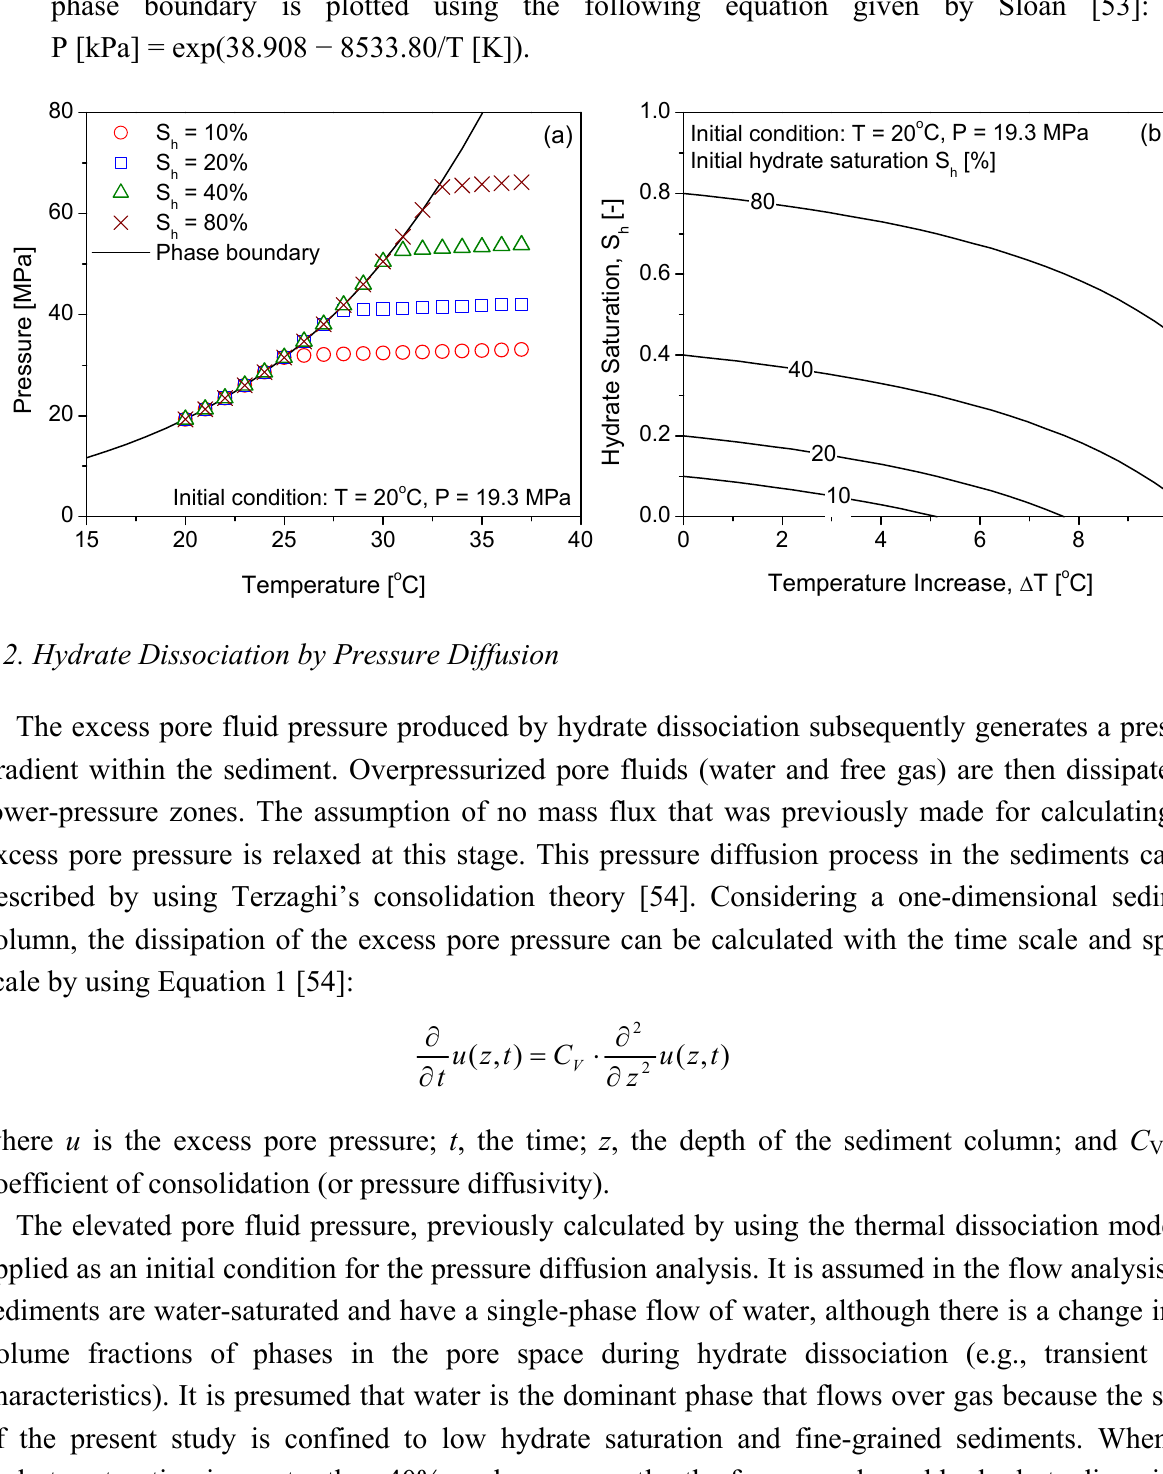
Figure 1. Thermal stimulation of methane hydrate-bearing sediments under a constant volume condition: ( a ) pressure evolution and ( b ) hydrate saturation remaining in pore spaces. Note that the initial gas saturation ( S ) is 0.1, and the thermodynamic g phase boundary is plotted using the following equation given by Sloan